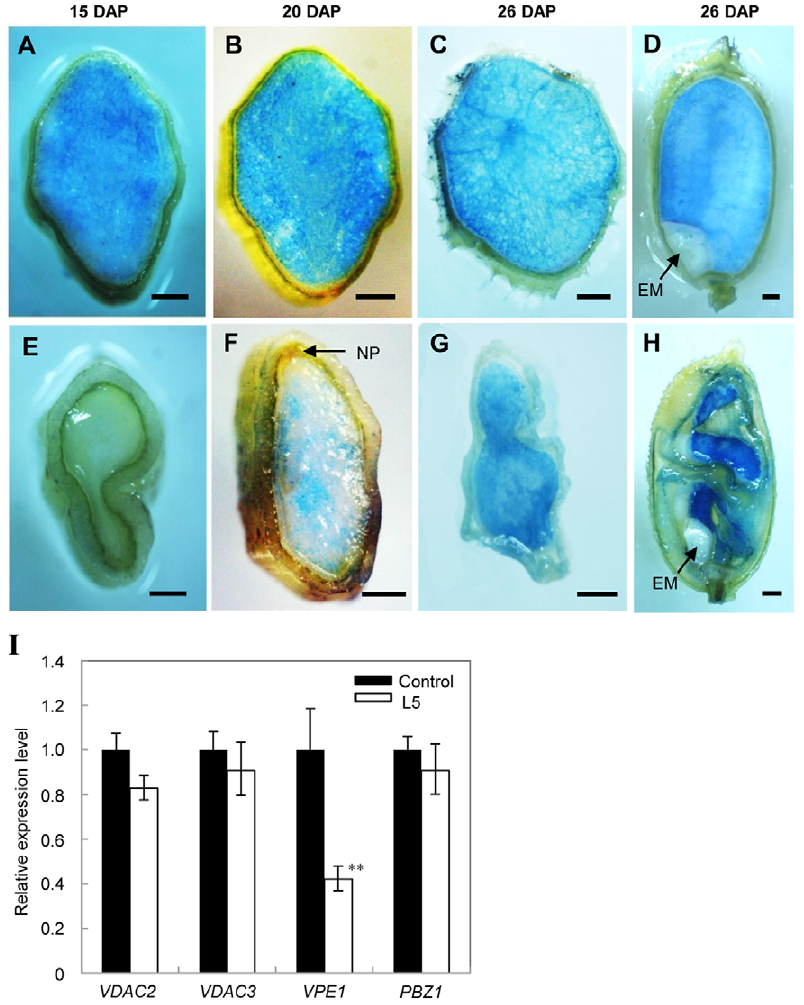
Figure 6. Detections of tissue degeneration. (A–D). Evan’s Blue staining of control seeds. (A-C) Transverse sections at 15 DAP, 20 DAP, and 26 DAP, respectively. (D) The longitudinal section at 26 DAP. The blue tissues indicate dead endosperm cells. (E–H). Evan’s Blue staining of m-seeds. (E– G) Transverse sections at 15 DAP, 20 DAP, and 26 DAP respectively. H Longitudinal sections at 26 DAP. Bar=500 m m in (A) to (H). EM, embryo. (I). Quantitative real-time PCR analyses of PCD-related genes in 7 DAP seeds of control and transgenic plants. ACTIN1 was used as an internal control. Error bar indicated the SD (n=3). ** indicates an extremely significant difference (P , 0.01) between control and transgenic lines.